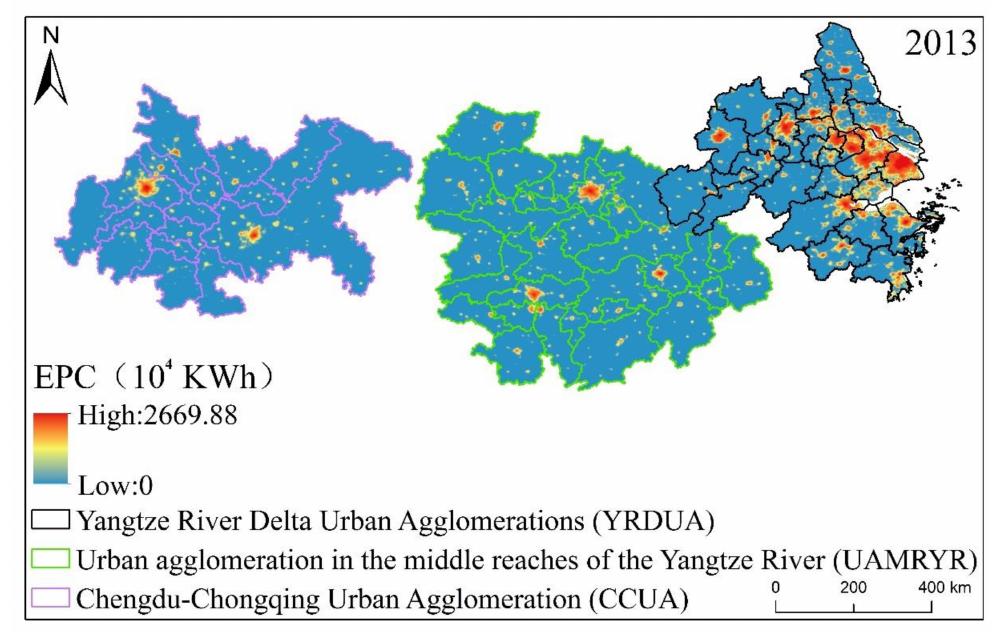
Figure 4. The estimated EPC in the three major urban agglomerations of YREB in 2013 based on intercalibrated NSL